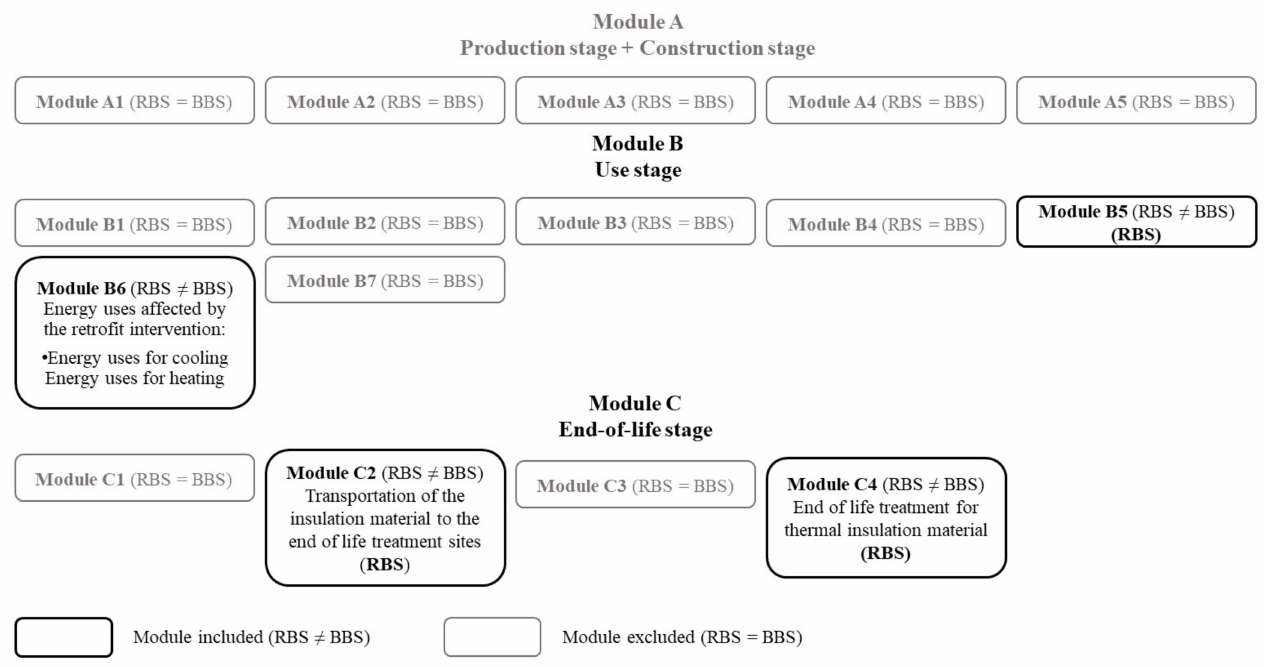
Figure 3. System boundary for FU ES —RBS versus